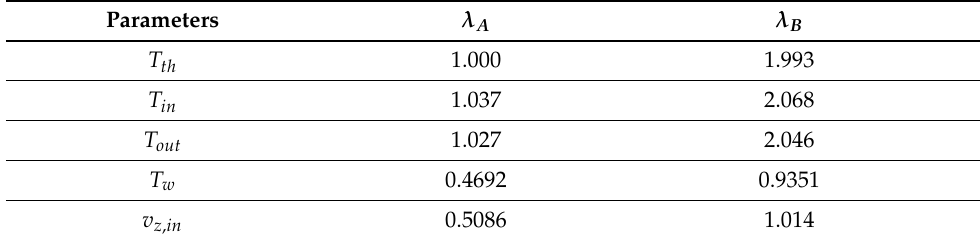
Table 4. Scaling ratio values used to attain a doubly accelerated energy charge and discharge